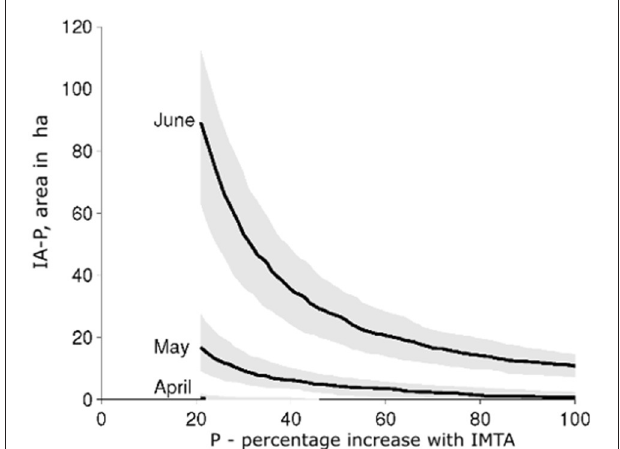
FIGURE 7 | IA P for dry weight as a function of P (%) for April 11th, May 11th, and June 11th (black curves). P (%) is the relative increase in dry weight compared to the same system without salmon farming activities, while IA P is the areal extent of the region experiencing at least this relative increase with IMTA. The shaded regions around the black curves represent the range of IA P values for 1 week before and after the specified dates.